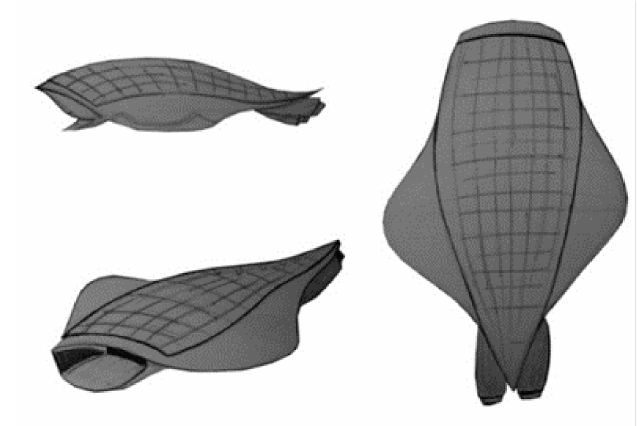
Figure 13. Natural Style Sketch.